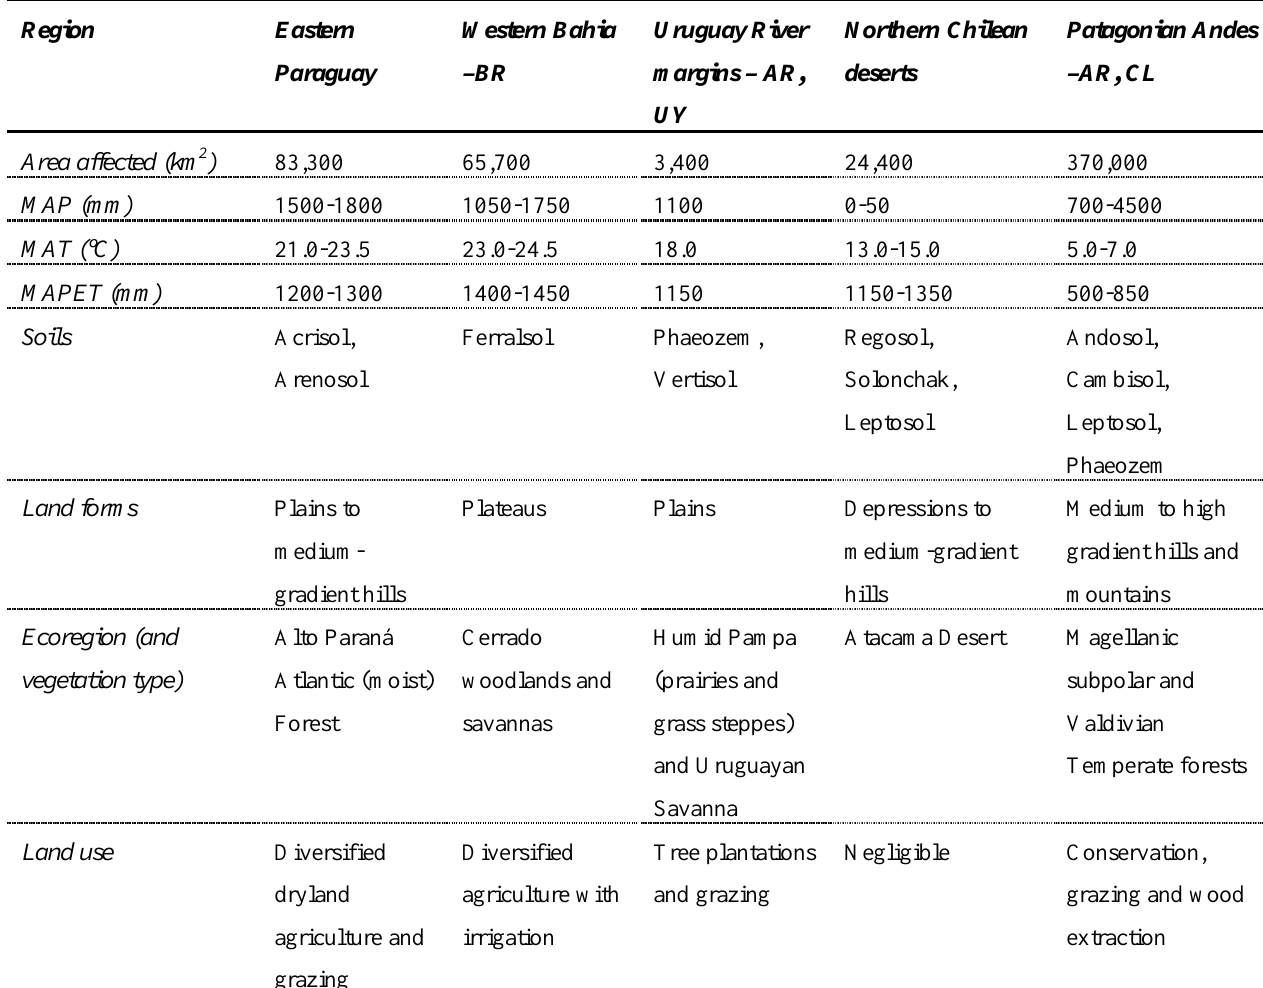
Table 2. Main physical characteristics of the focal regions used to evaluate NDVI trends results. Acronyms: MAP, Mean annual precipitation; MAT, Mean annual temperature; MAPET, Mean annual potential evapotranspiration; AR, Argentina; BR, Brazil, CL: Chile; UY, Uruguay. Ecoregion name following Olson et al. [87], climatic information was extracted from CRU 2.0 [88] and soil type and land form from the SOTER-Latin America and the Caribbean [89] databases. The potential evapotranspiration was calculated using the same database and following Penman-Monteith method [90]. The calculation of the areas affected by changes was extracted from the superposition of the three series´ average